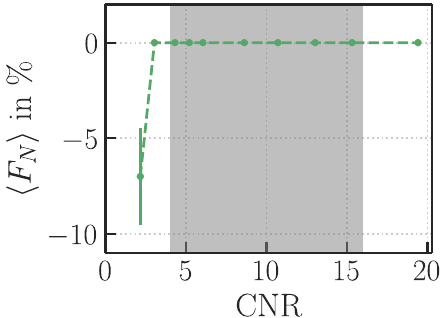
Figure 9. Mean relative error (cid:104) F N (cid:105) for different CNR values. For each CNR value, n = 100 thermograms were investigated. The gray region marks CNR values found in real thermograms, CNR = 10 ± 1 σ , with σ = 6. The error bar indicates the standard deviation of the